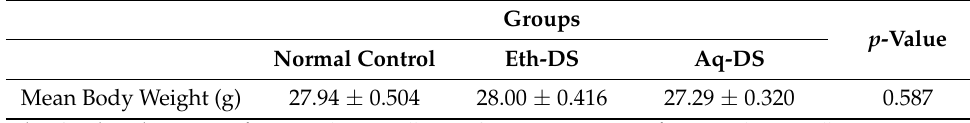
Table 1. Mean body weight ± SD of normal and extract treated groups.